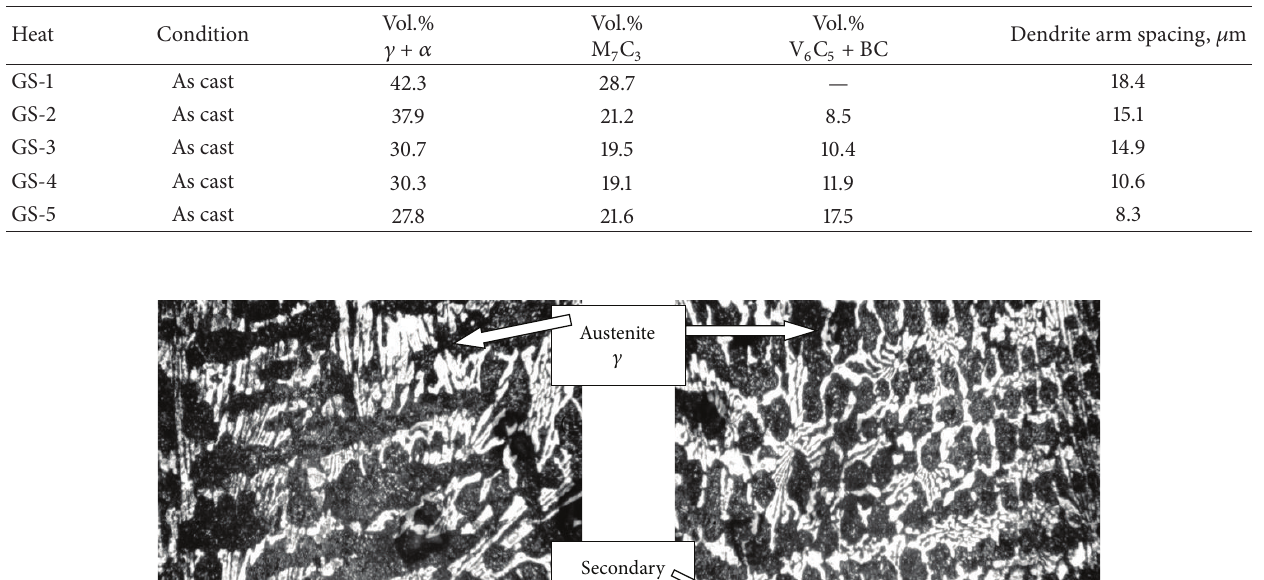
Table 2: Volume fraction of austenite and carbides in cast alloys.